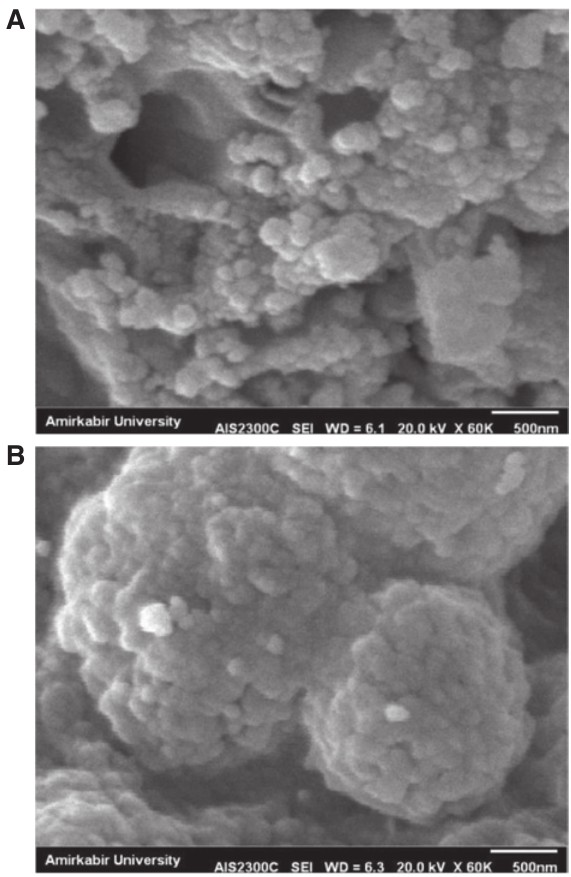
Figure 8: Soybean oil polymerization by Cu complex catalyst at 300 ° C.